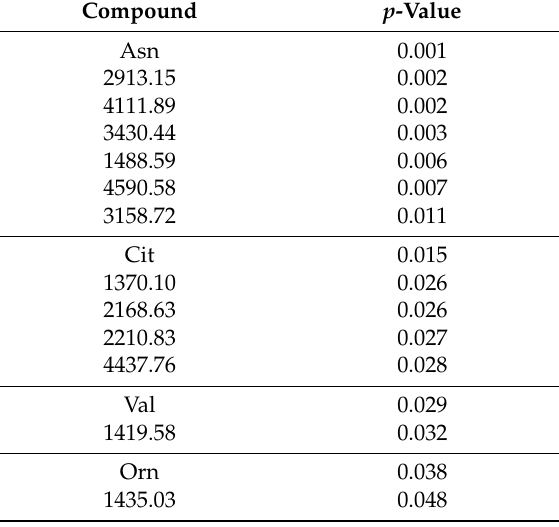
Table 2. Peptide ions ( m / z ) and amino acids that differ significantly between the study and control group, identified by univariate analysis ( t -test or Mann–Whitney U